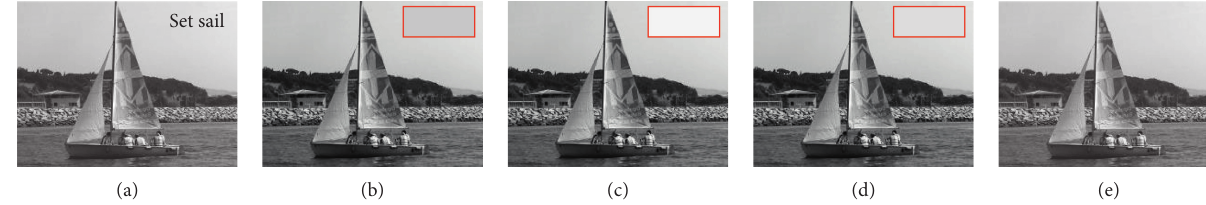
Figure 10: The effect of the letter removal grayscale image restoration. (a) Original image, (b) Criminisi algorithm result, (c) adaptive repair algorithm result, (d) sparsity repair algorithm result, and (e) algorithm result of this